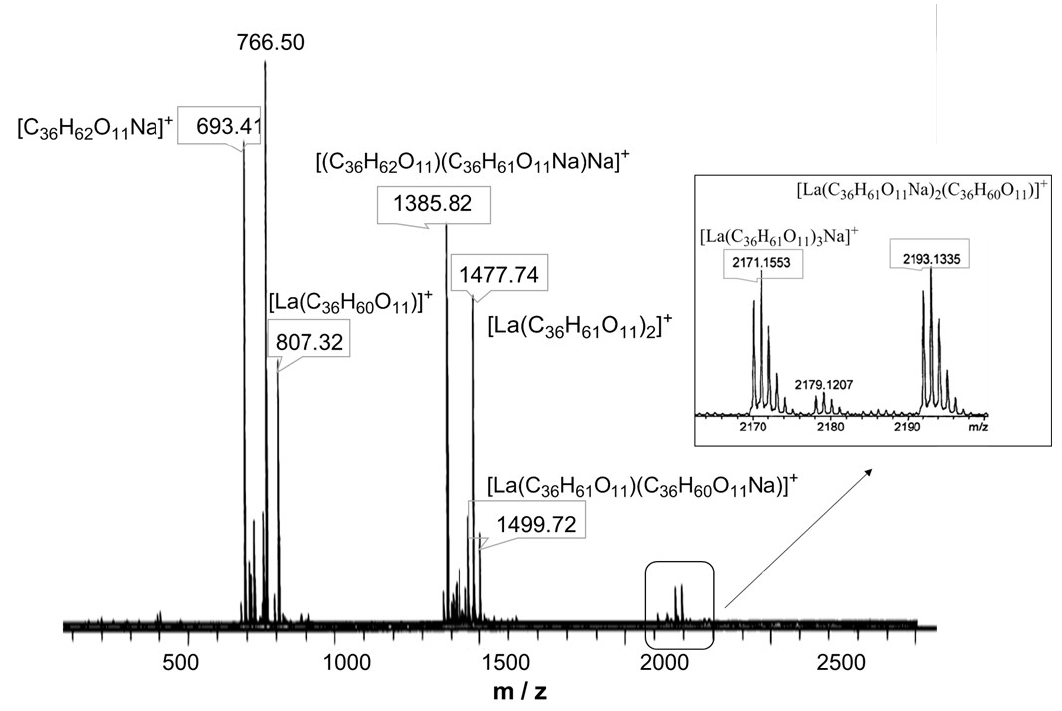
Figure 2: ESI-MS spectrum of complex